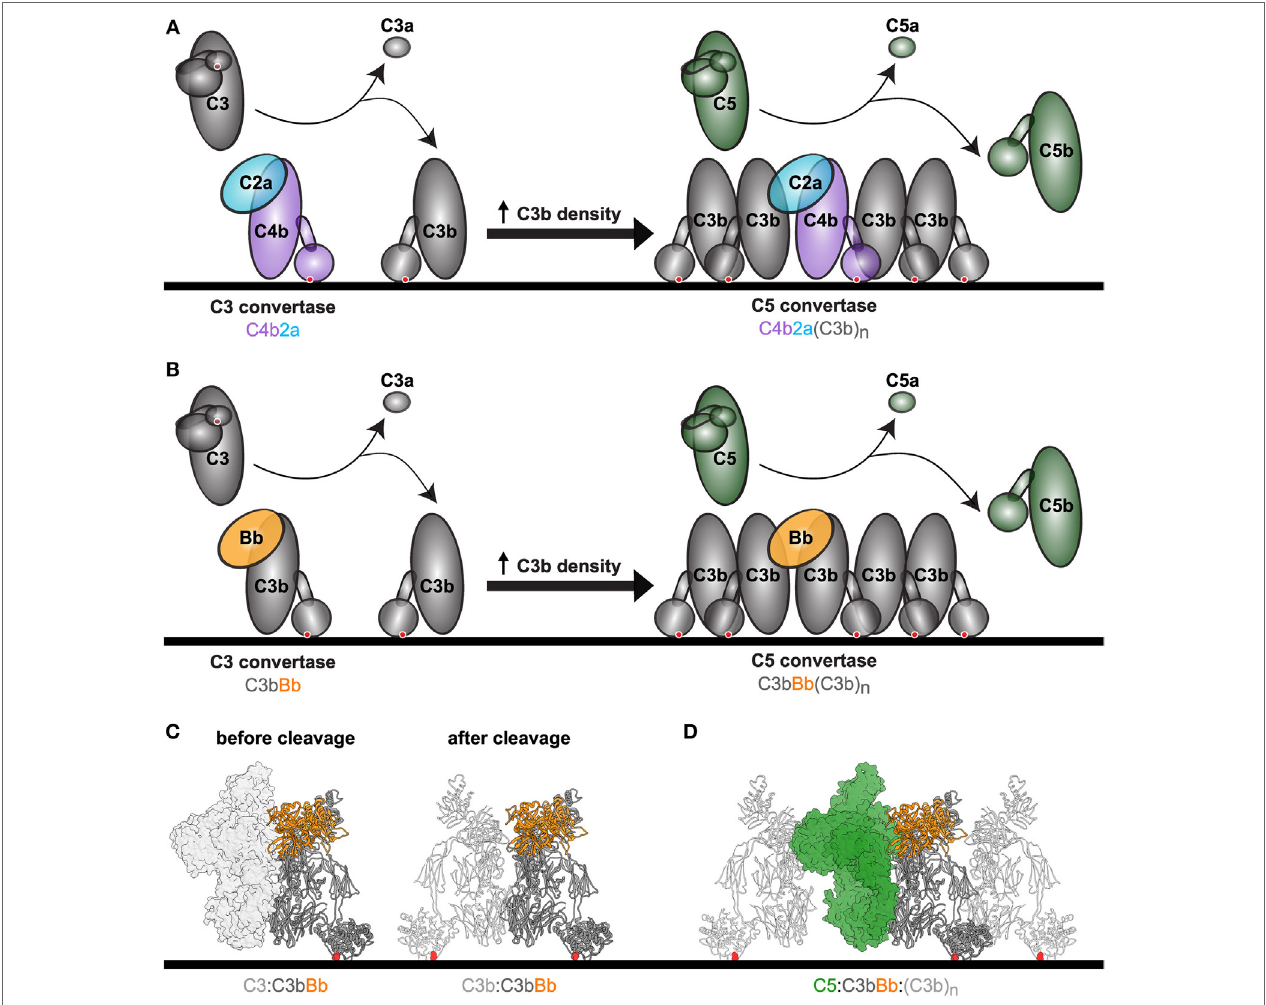
FigUre 1 | Complement convertases mediate C3 and C5 conversion. (a) Upon complement activation, C3 convertases consisting of either C4b2a (CP and LP) or (B) C3bBb [alternative pathway (AP)] form on the cell surface. Conversion of C3 results in deposition of C3b molecules via the thioester (red dot), which form the basis for new AP convertases (amplification loop) or associate with existing C3 convertases to form C5 convertases. These accessory C3b molecules (C3b n ) enable efficient C5 conversion, however, the molecular mechanisms underlying this process are not clear. Shown are C4b (purple), C2a (blue), C3 and cleavage products C3b/C3a (gray), Factor B (orange), C5 and cleavage products C5b/C5a (green). (c) Structural models of the C3 convertase C3bBb with its substrate C3 before and after cleavage. Models are based on structures of the C3bBb-SCIN dimer (PDB: 2WIN). The convertase is shown in ribbon representation, with C3b in dark gray and Bb in orange. On the left, the substrate C3 (light gray surface) is shown before cleavage. On the right, the product C3b (light gray licorice) is shown after cleavage. The red dots highlight the thioester. (D) Structural model of the previously proposed AP C5 convertase with its substrate C5. At a high density of C3b molecules, C5 is recruited to the target surface and can be cleaved after binding of Bb to C3b. The exact molecular arrangement of the C5 convertases remains unknown. This structural model is based on the CVF-C5 crystal structure (PDB: 3PVM), with accessory C3b molecules added manually surrounding the convertase and C5. CVF (cobra venom factor) is a C3b homolog that lacks the thioester domain and forms stable C5 convertases when associated with Bb in solution. Structure is shown in ribbon representation with C3b (dark gray), Bb (orange), accessory C3b molecules (light gray licorice), and C5 (green surface).